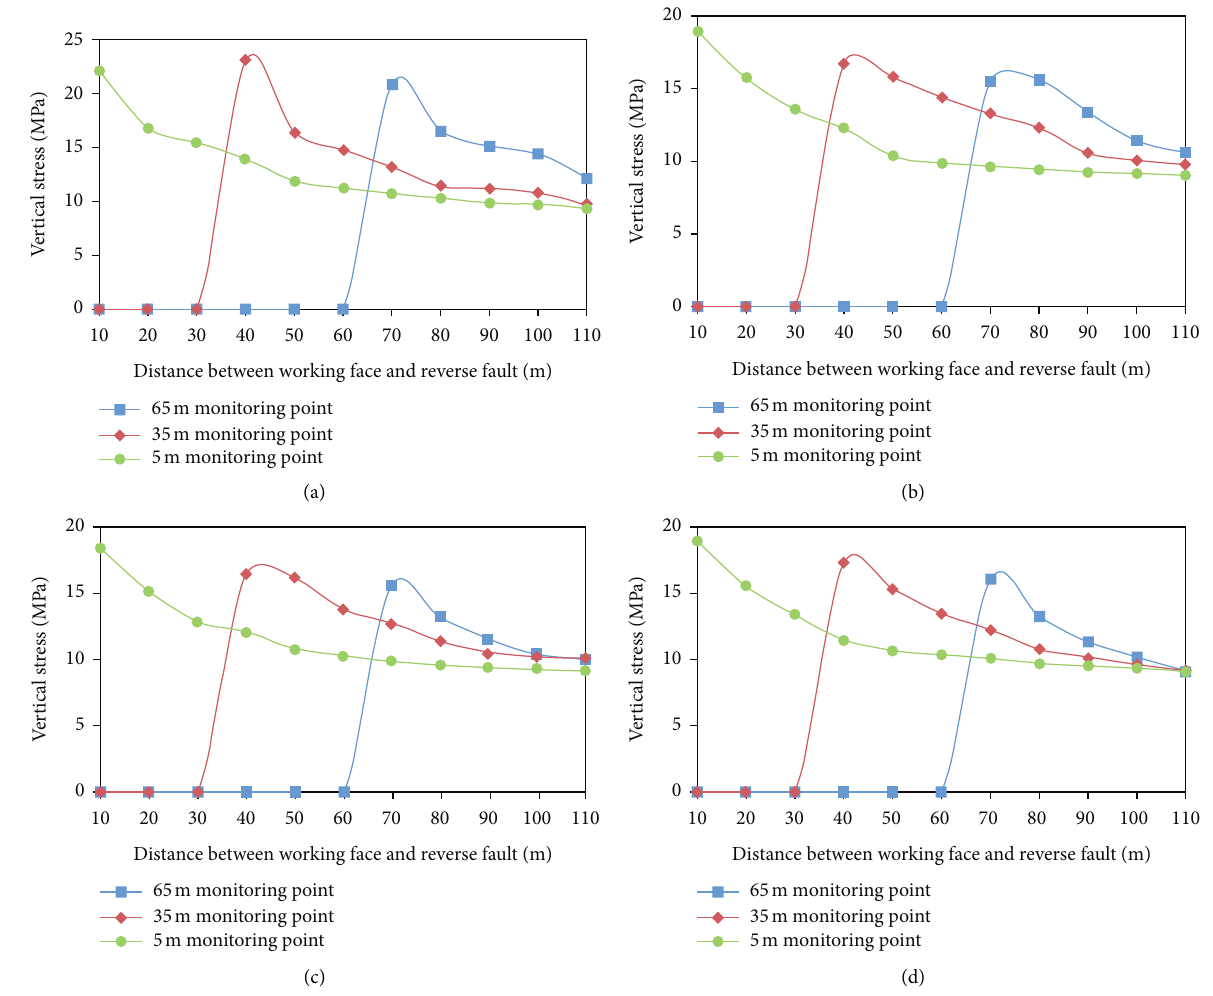
Figure 11: Variation curve of the vertical stresses at the monitoring points with different dip angles. (a) The dip angle of reverse fault is 30 ° . (b) The dip angle of reverse fault is 45 ° . (c) The dip angle of reverse fault is 60 ° . (d) The dip angle of reverse fault is 75 ° .